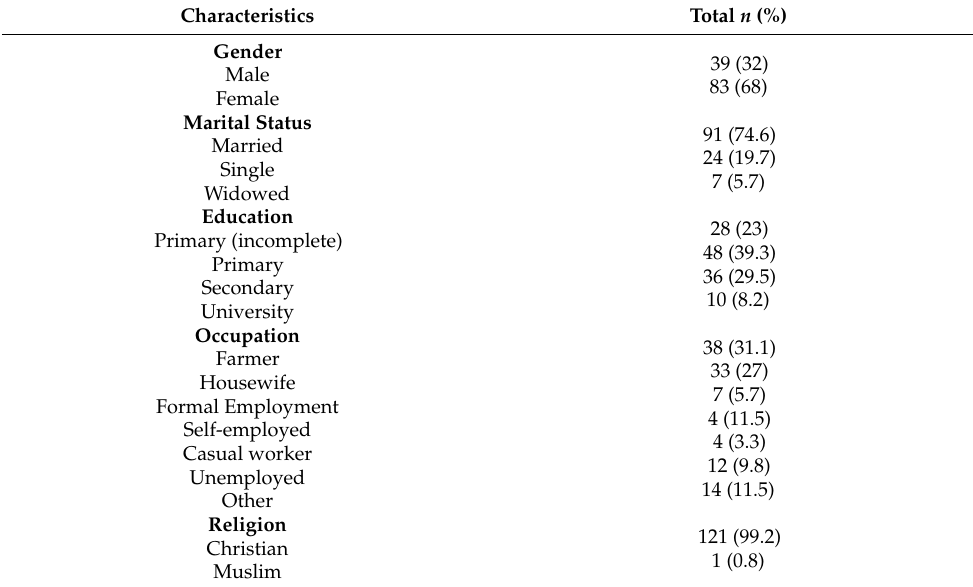
Table 3. Demographic characteristics of the focus group discussion participants.